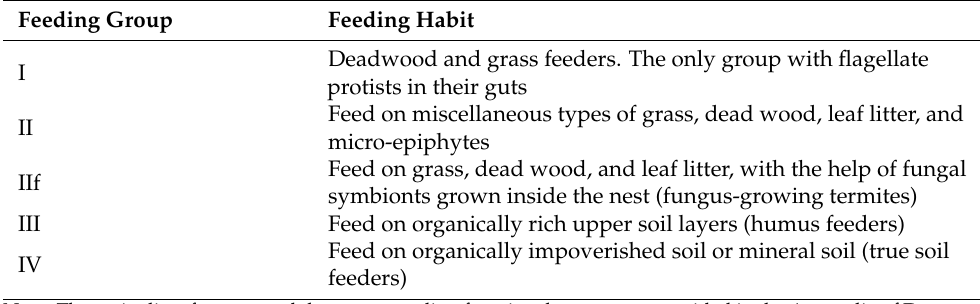
Table 2. Termite functional groups based on feeding habits